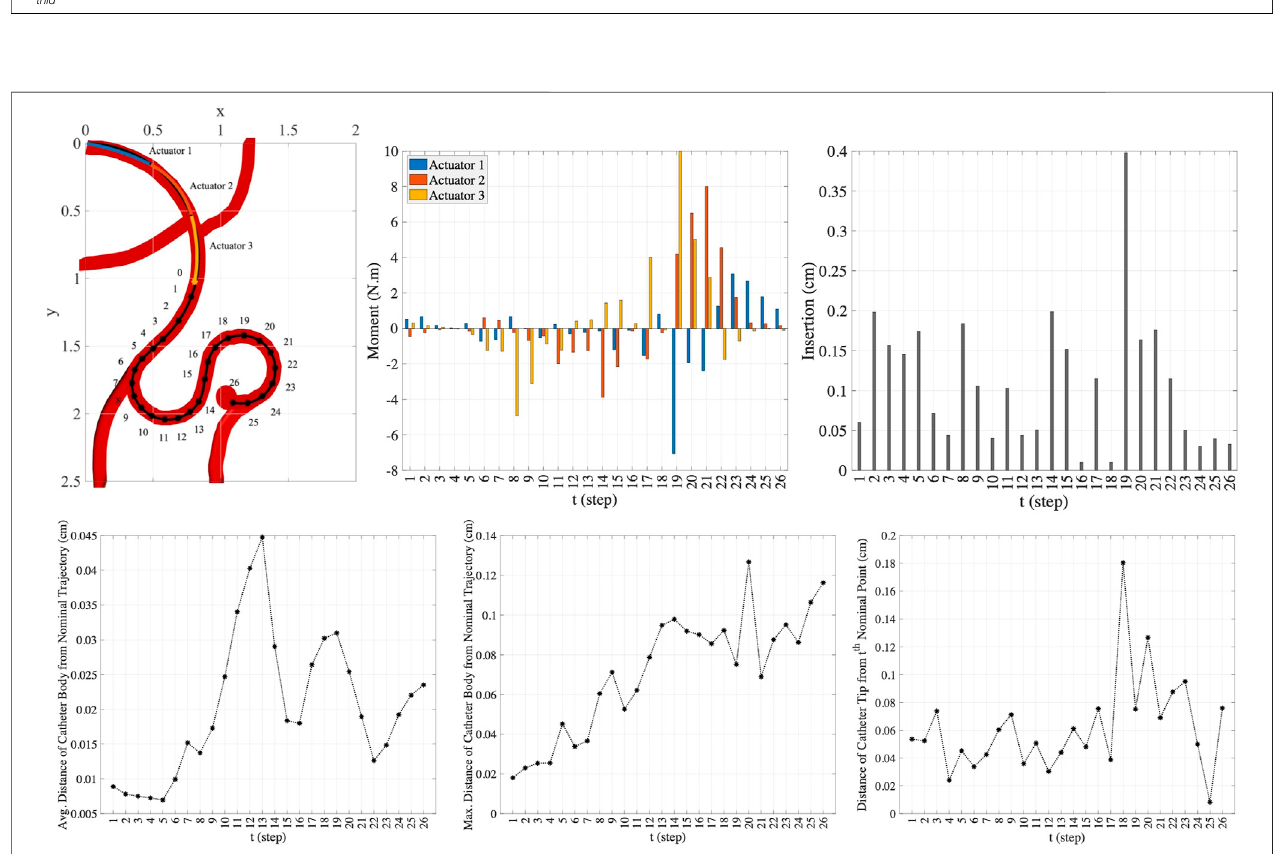
FIGURE9| Thenominaltrajectoryandthemomentsandtheinsertiondepthappliedbythree-actuatorcatheterin26steps (toprow) andtheprecisionachievedin this trajectory tracking (bottom row) .